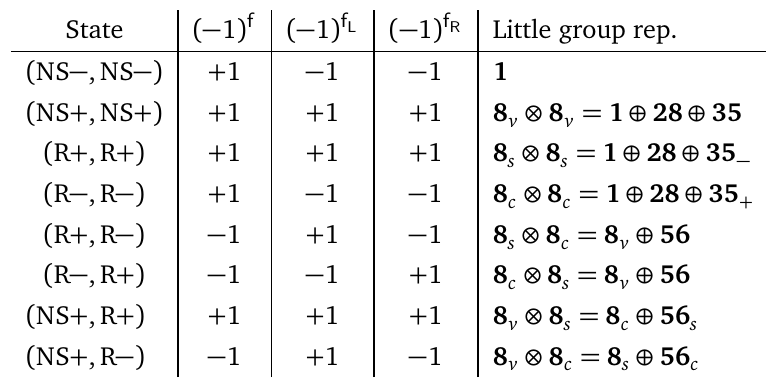
Table 2: Fermion parity and representations of the low-lying states of the closed NSR